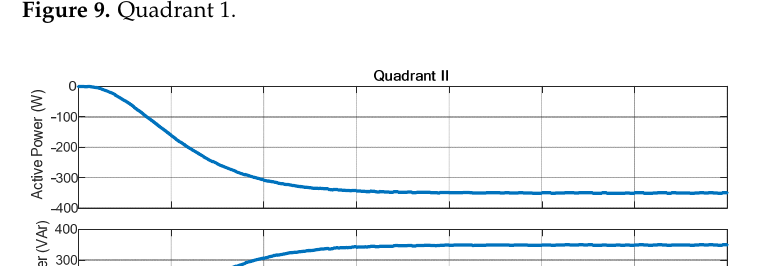
Figure 9. Quadrant 1.